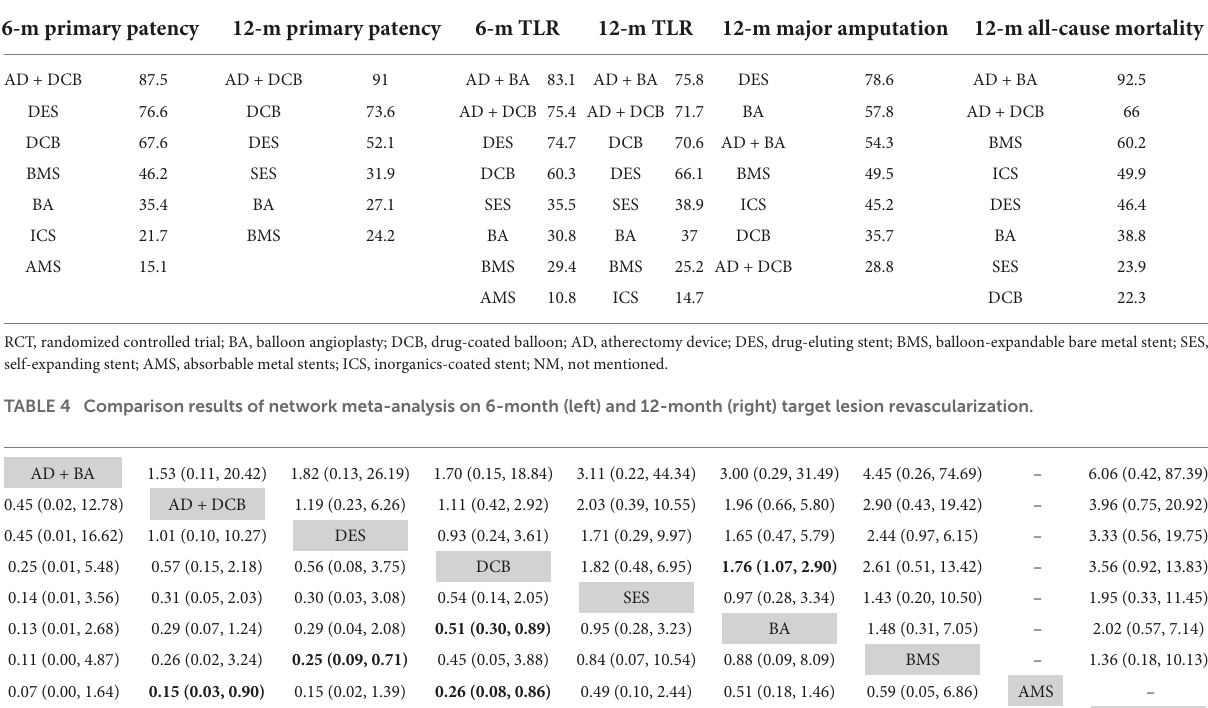
TABLE 3 Surface under the cumulative ranking curve values of endovascular modalities for all terms of analysis.